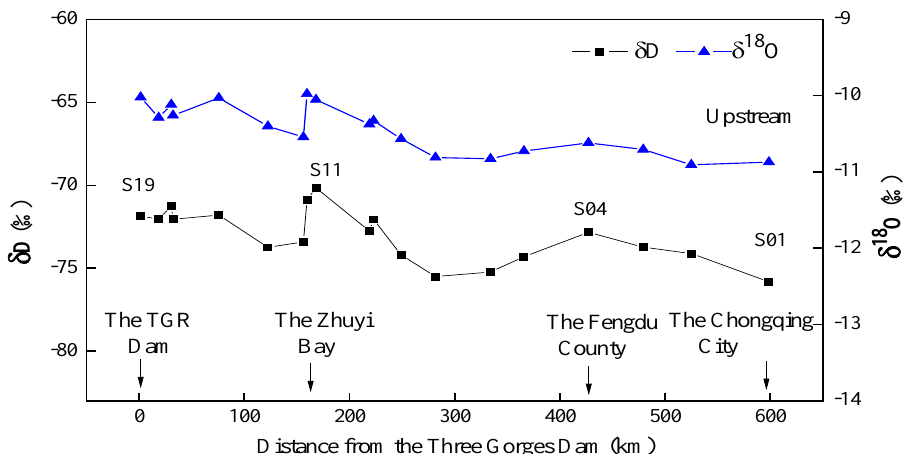
Figure 2. Spatial variation of the δD and δ 18 O stable isotopes along the TGR mainstream during the wet season (August 2015). Water 2018 , 10 , x FOR PEER REVIEW